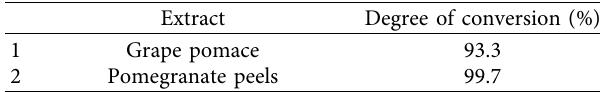
Figure 7: The Ag + |Ag electrode potential variation with time during the “green” synthesis with extracts at 80 ° C. Table 6: The degree of conversion of Ag in the “green”